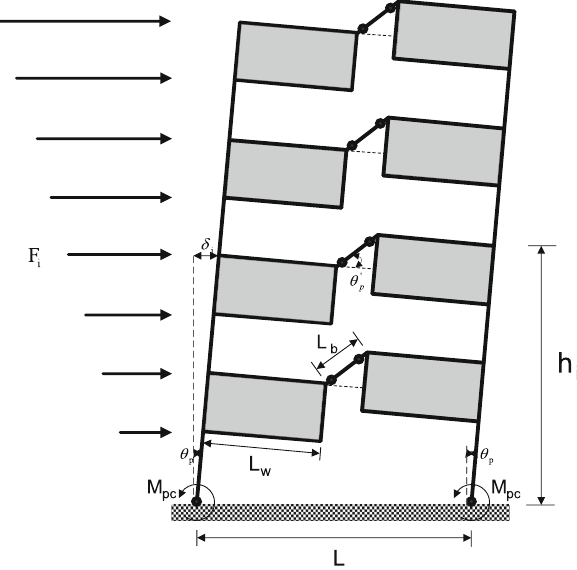
Fig. 12 Desired deformed configuration of the model